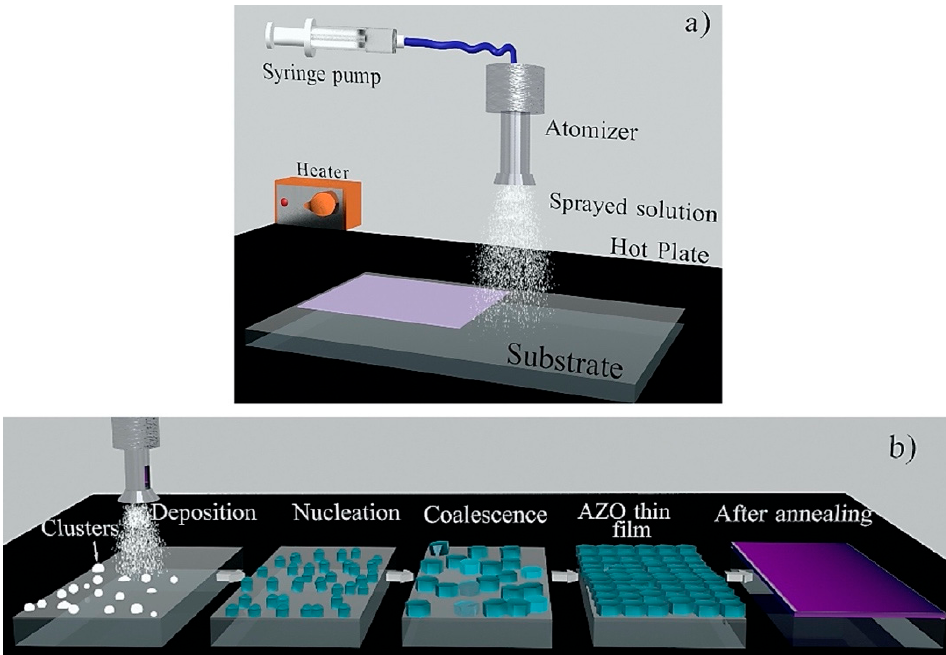
Figure 5. ( a ) Simplified schematic of the spray pyrolysis system and the main stages ( b ) of the ZnO-based film growth process, starting from small sprayed clusters, which undergo nucleation and coalescence, forming a continuous polycrystalline layer that then acquires a light-purplish color during substrate heating (via the hot plate), and finally changes to a darker purple after the rapid thermal annealing (RTA) post-process. Reproduced with permission from ref. [63].